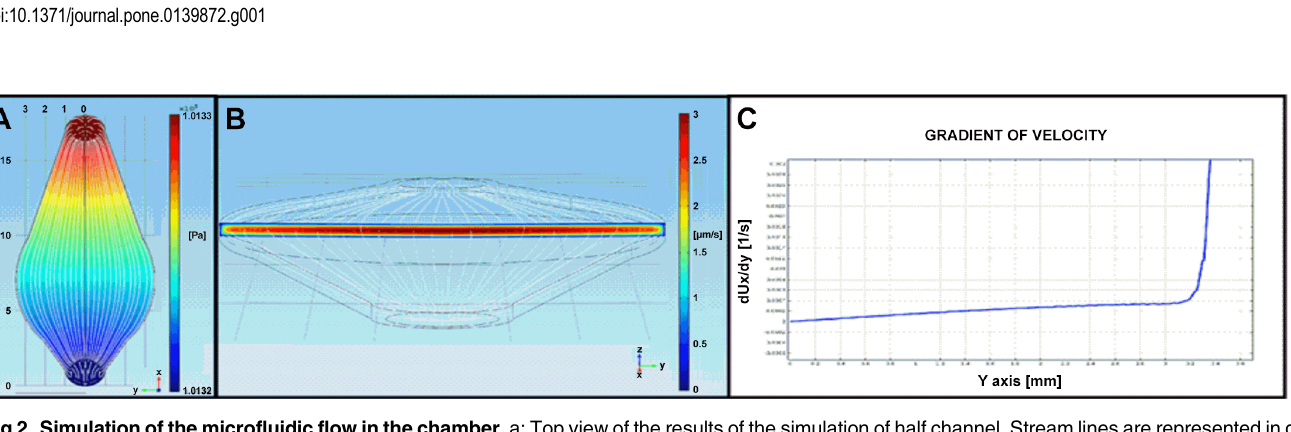
PLOS ONE | DOI:10.1371/journal.pone.0139872 October 5,